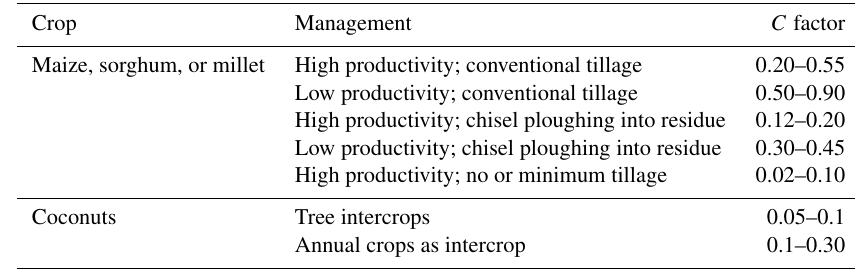
Table 10. Examples of where C factor accounts for crop management from Morgan (2005) and David